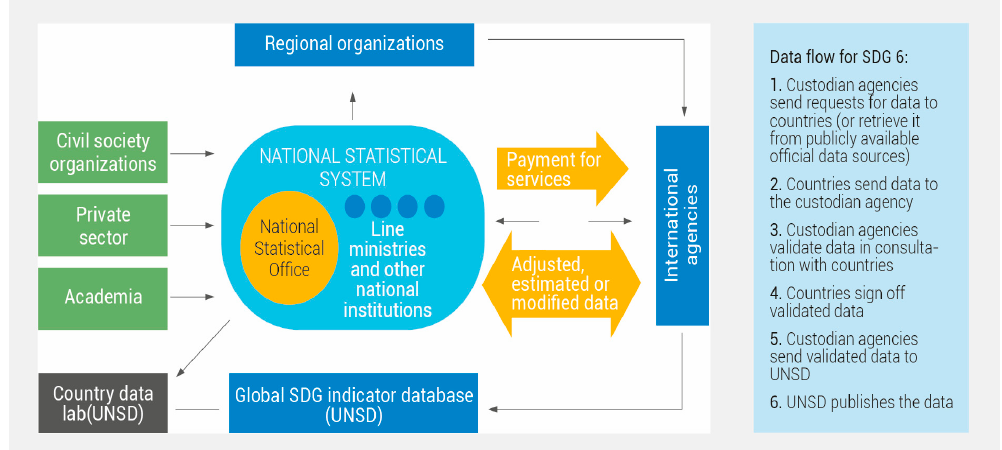
Figure 4. Data flow in SDG reporting, highlighting the central role of the National Statistical System. Source: